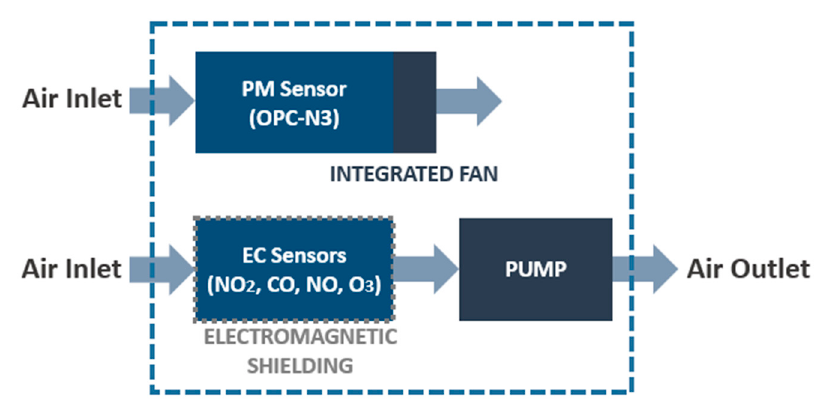
Figure 3. Airflow Figure 3. Airflow diagram.